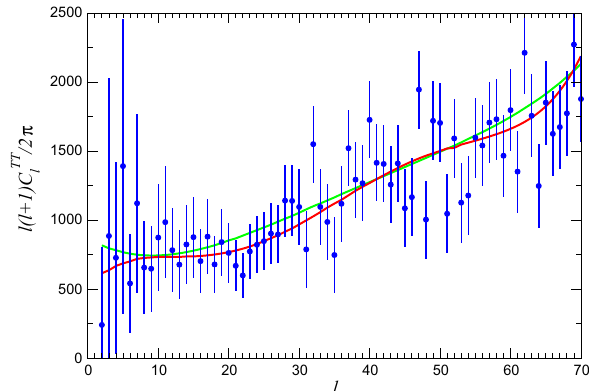
Fig. 1 The fit (red line) to (cid:2) ≈ 2, (cid:2) ≈ 20 and (cid:2) ≈ 60 suppression of the TT CMB power spectrum as described in the text. Points with error bars are from the Planck Data Release [14]. The green line shows the best standard Λ CDM power-law fit to the Planck CMB power spectrum